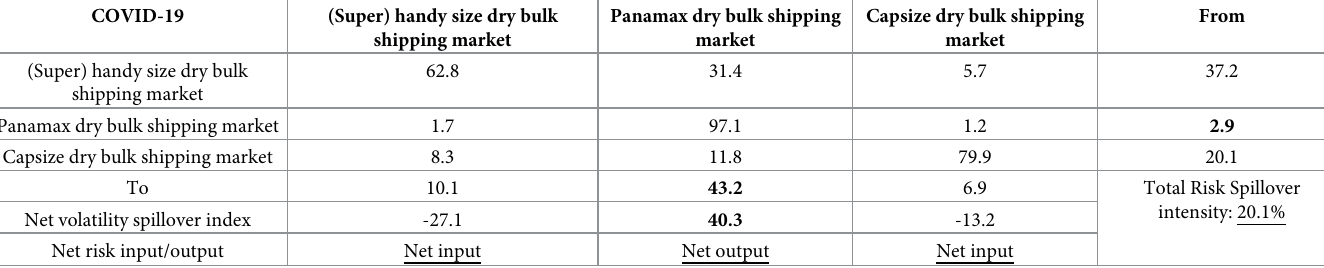
Table 10. Risk volatility spillover table of the dry bulk shipping market during the study period of COVID-19. COVID-19